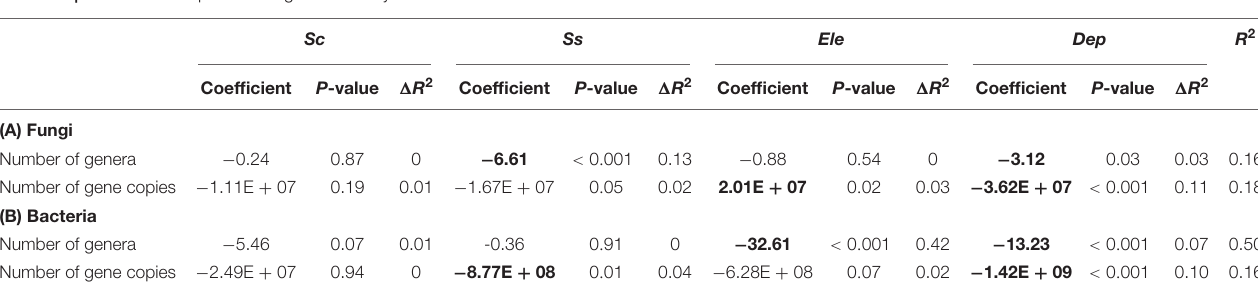
TABLE 1 | Results of multiple linear regression